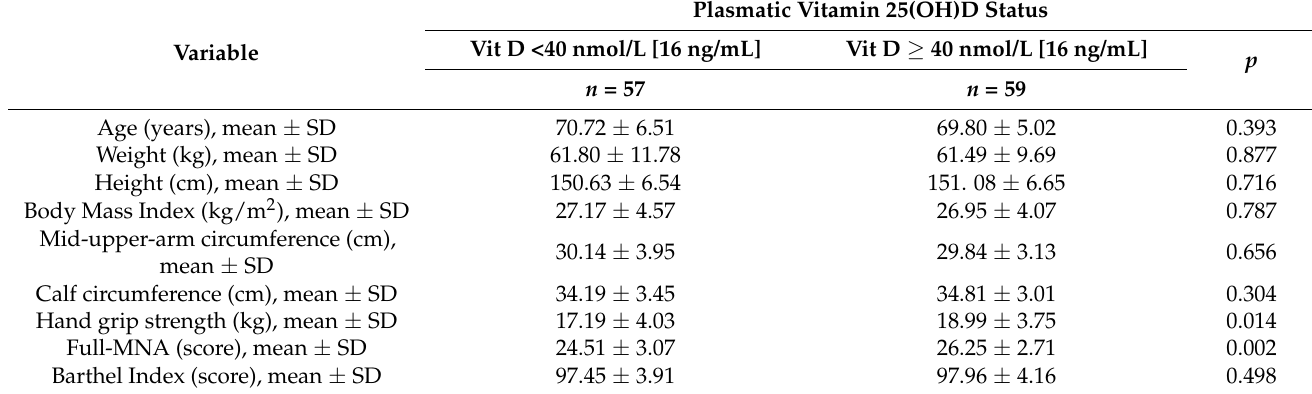
Table 3. Anthropometric measurements, handgrip strength, MNA, and Barthel Index according to plasma 25(OH)D concentration in community dwelling Mexican older